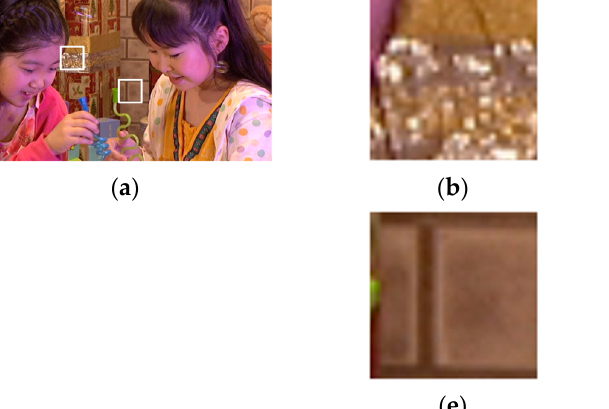
Figure 11. Reconstructed results of complex and monotonous areas by the proposed method: ( a ) BlowingBubbles —416 × 240; ( b ) original of complex area; ( c ) QP27; ( d ) QP37; ( e ) original of monoto- nous area; ( f ) QP27; ( g ) QP37.